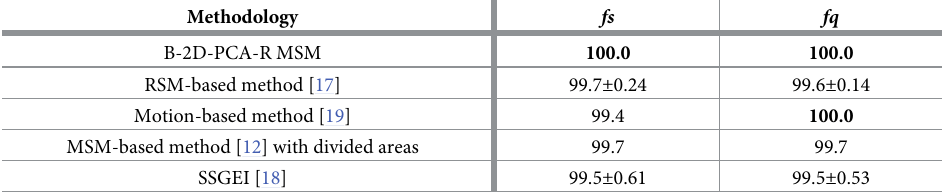
Table 2. Comparison of the Correct Classification Rate (CCR) [%] of each of the B-2D-PCA-R MSM, the RSM- based gait recognition [17], the motion-based method [19], the MSM-based method with divided areas [12], and